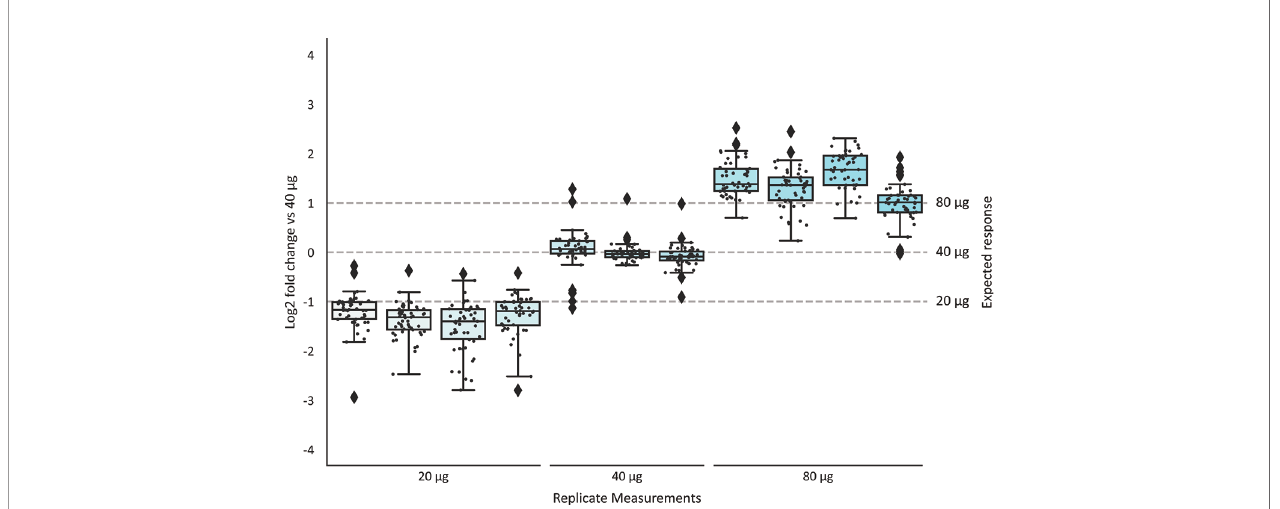
FIGURE 3 | Accuracy and reproducibility of quanti fi cation of individual sIgA clones. The top 50 most intense clones from a human milk colostrum sIgA standard were quanti fi ed relative to a monoclonal mIgA1 of known quantity. The detected quantities of each clone in all samples were compared to the levels in one sample with 40 µg sIgA, and the fold-change was plotted. Replicates of the same injection amount (40 µg) showed no signi fi cant fold-change. Clone intensities in the 20 µg replicates are detected at half the abundance (-1 log 2 fold change), and clone intensity in the 80 µg replicates were detected at double the abundance. Boxplots indicate the median, 25 th and 75 th percentile, whiskers range to 1.5 times IQR. Values inside this range are depicted as black dots. Outliers (> 1.5 times IQR) are indicated as black diamonds. Supplemental Figure S2 depicts similar boxplots, considering all clones detected in all replicates (n=128) instead of the top50 most intense clones shown